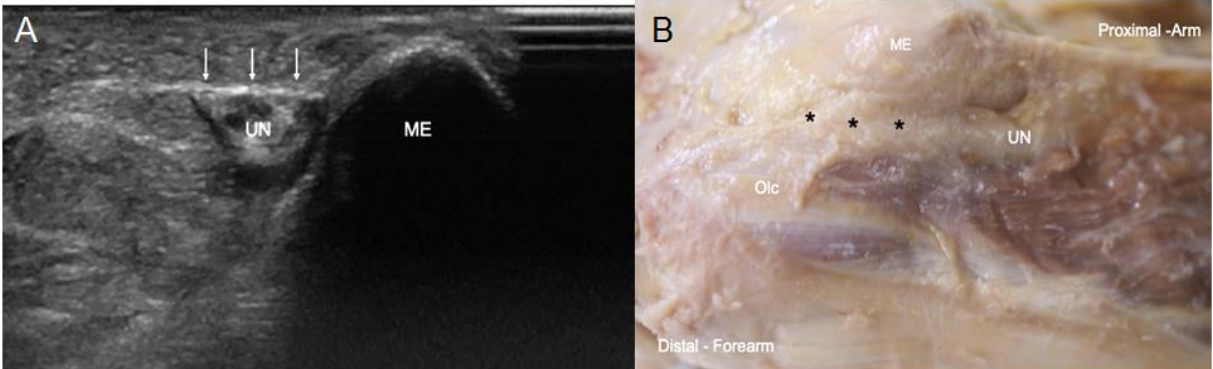
Figure 4. ( A ) US view of the UN at the osteofibrous tunnel covered by Osborne’s fascia (white arrows), laterally to the medial epicondyle (ME) ( B ) Anatomical view of the Osborne’s fascia marked with black asterisks and the UN passing between the olecranon (Olc) and the medial epicondyle